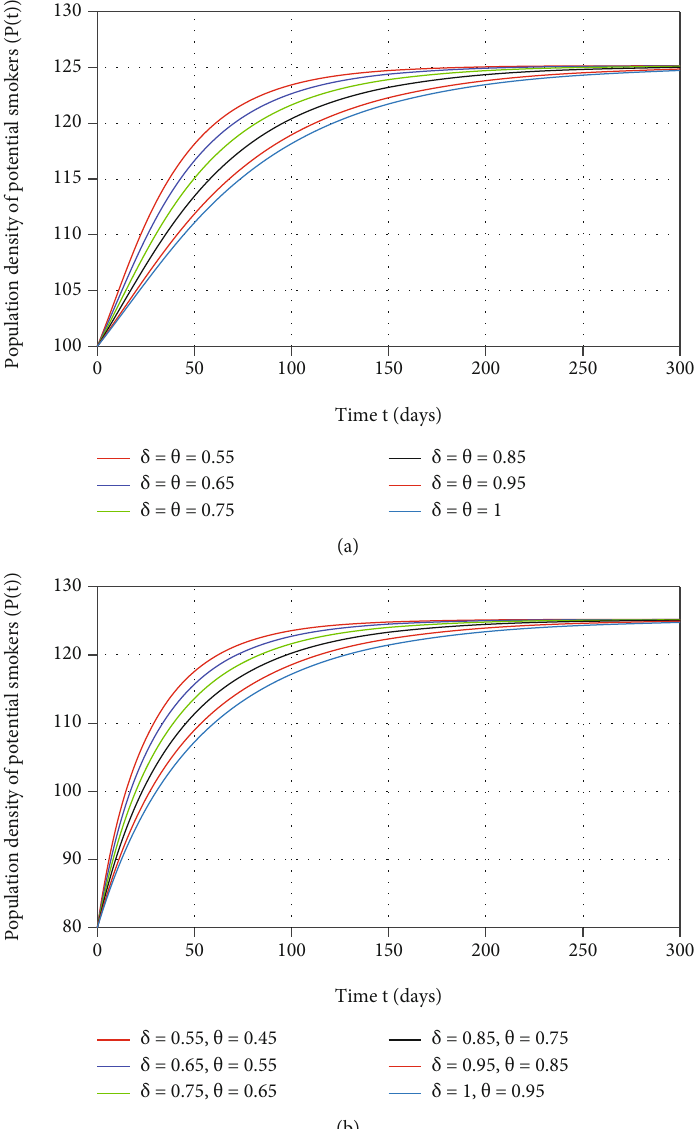
= 100 , 80 in the model under 0